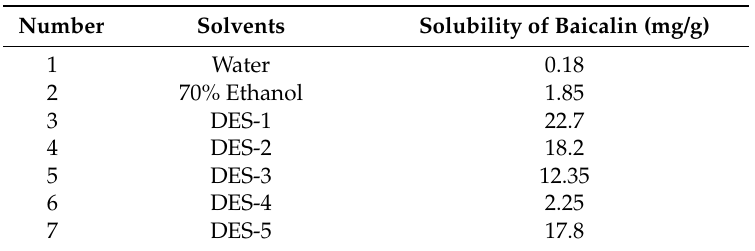
Table 2. Solubility of baicalin in different